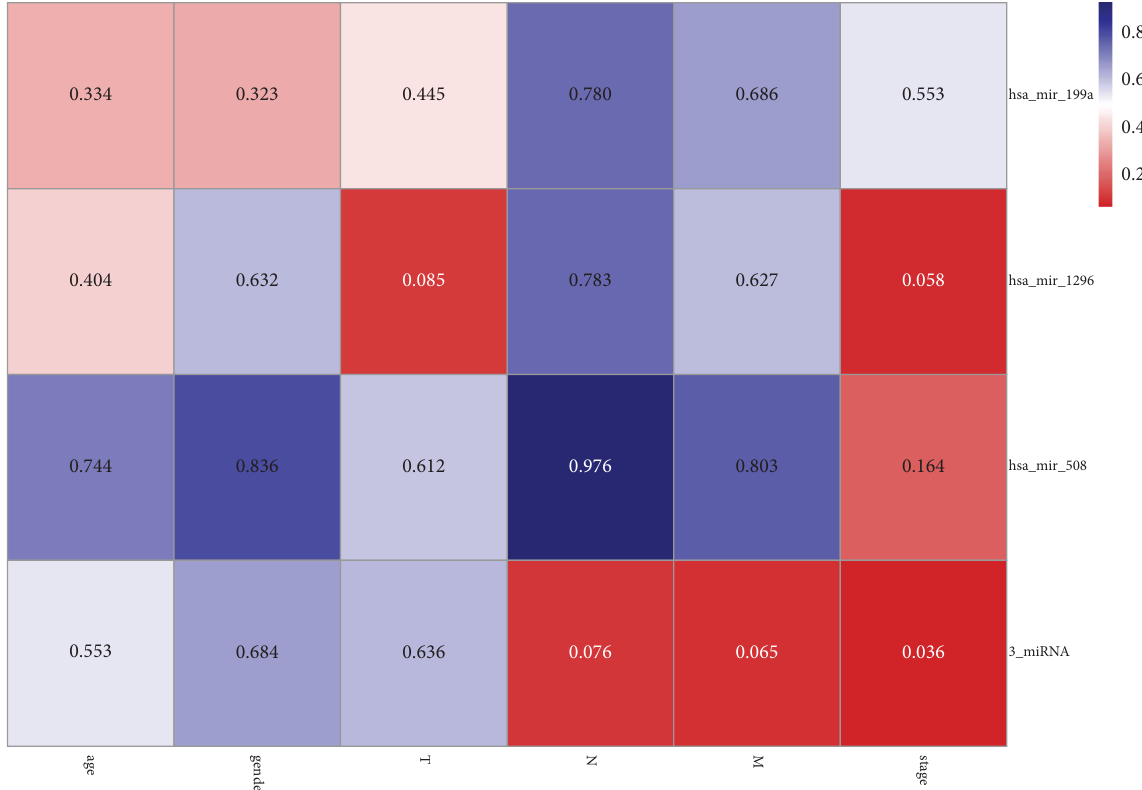
Figure 4: Te heatmap of miRNAs signature expression and clinical characteristics (the blue and the red colors represent higher and lower P value,